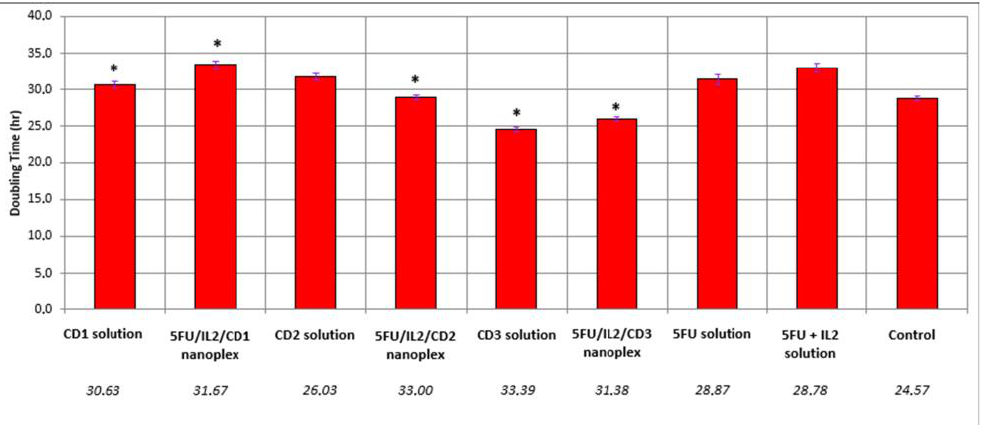
Figure 2. Graph of the duplication time of CT26 cells due to different formulations applied, by xCELLigence Real-Time cell analysis. The control group was treated with the DMEM and was considered as 100% (n = 4) (* p < 0.05 compared with 5-FU solution).